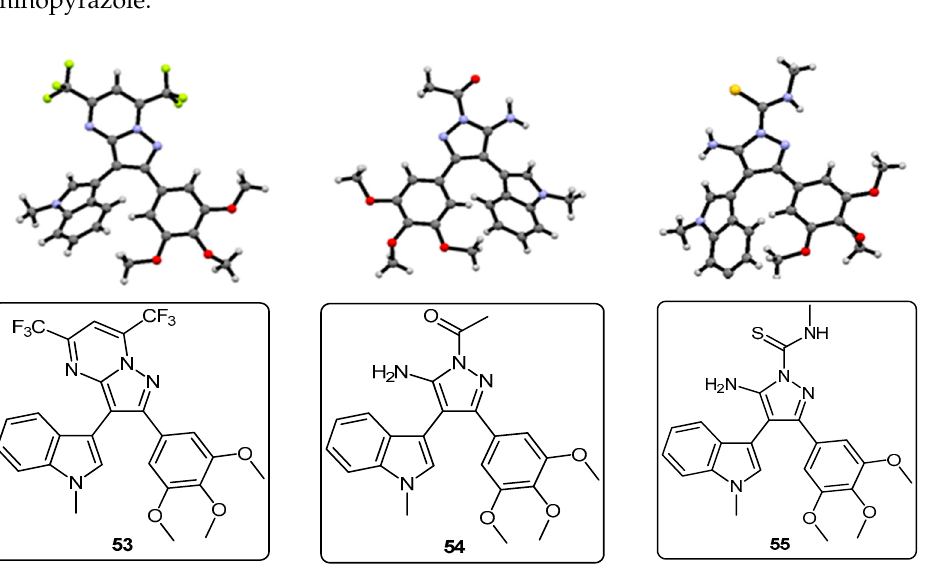
Figure 6. Crystal structures of the bicyclic pyrazolo[1,5- a ]pyrimidine 53 and monosubstituted aminopyrazoles 54 and 55 .